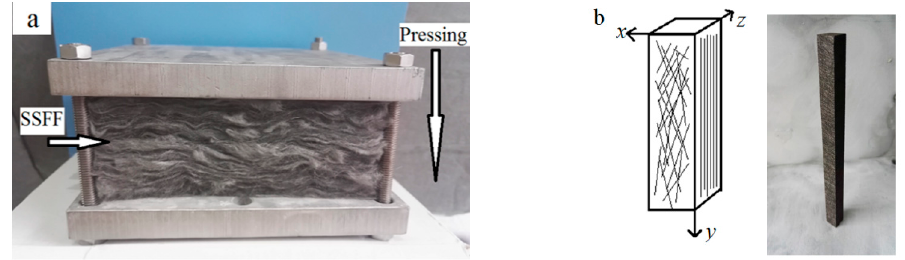
Figure 1. ( a ) Green 316L stainless steel fiber felts (SSFFs) compact (un-pressed) in steel mold; ( b ) schematics and photograph of 316L SSFF tensile sample.